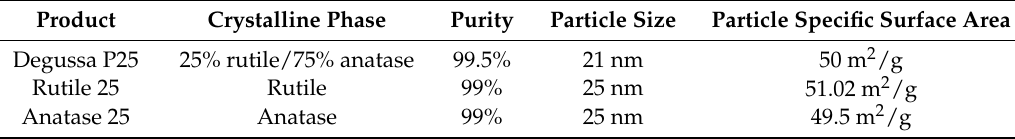
Figure 1. Morphological characterization of nano-TiO 2 A25, R25, and P25 via TEM. Table 1. Physicochemical properties of the nano-TiO 2 used in this study.